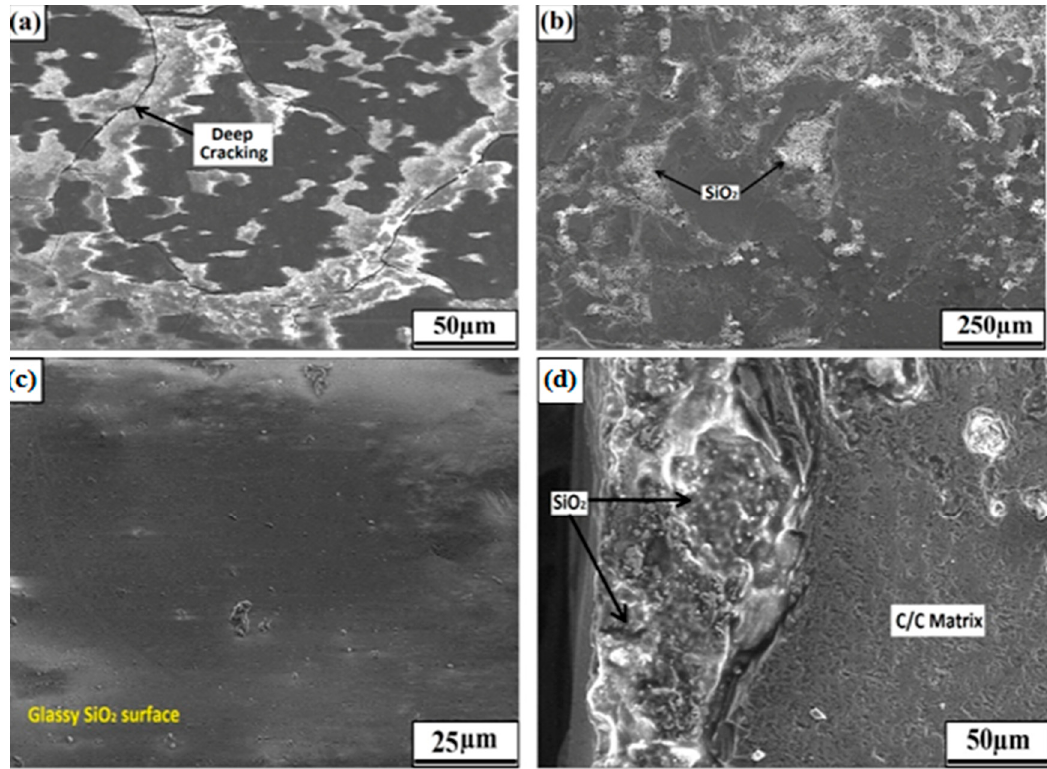
Figure 7. SEM image of MoSi 2 /SiC coating after oxidation at 1773 K: ( a ) surface, ( b ) cross-section; SEM image of MoSi 2 -Si 3 N 4 /SiC coating after oxidation at 1773 K: ( c ) surface, ( d ) cross-section.